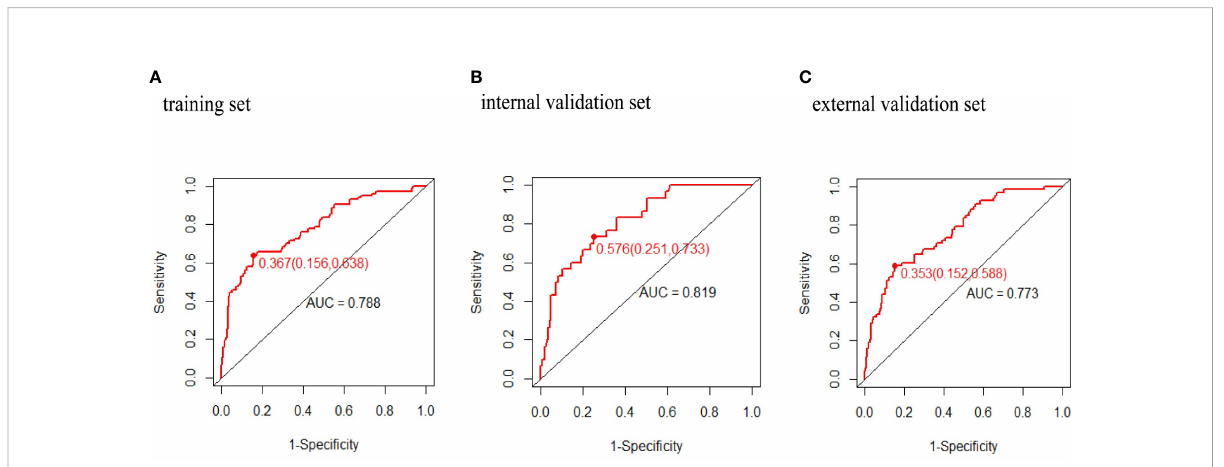
FIGURE 4 Receiver operating characteristic curves of macrosomia risk nomogram prediction. Receiver operating characteristic curve (ROC) of the (A) training set, (B) internal validation set, (C) external validation set. AUC, area under the receiver operating characteristic